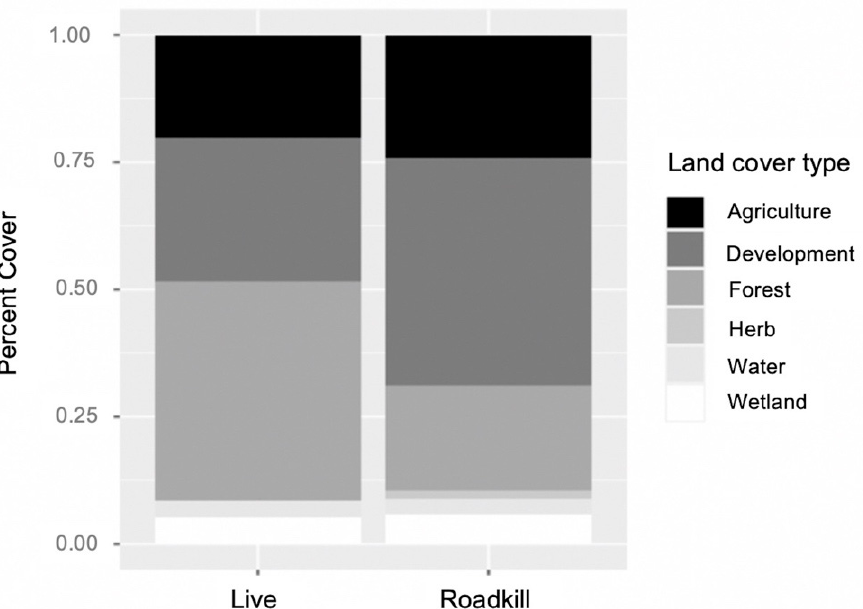
Figure 1. Comparison of land cover types within 8.7 ha buffer of live versus roadkill presence locations for nine-banded armadillos in southern Illinois during 2016–2020. Locations of live animals were surrounded by a higher percentage of forest cover, while roadkill had a higher percentage of development.